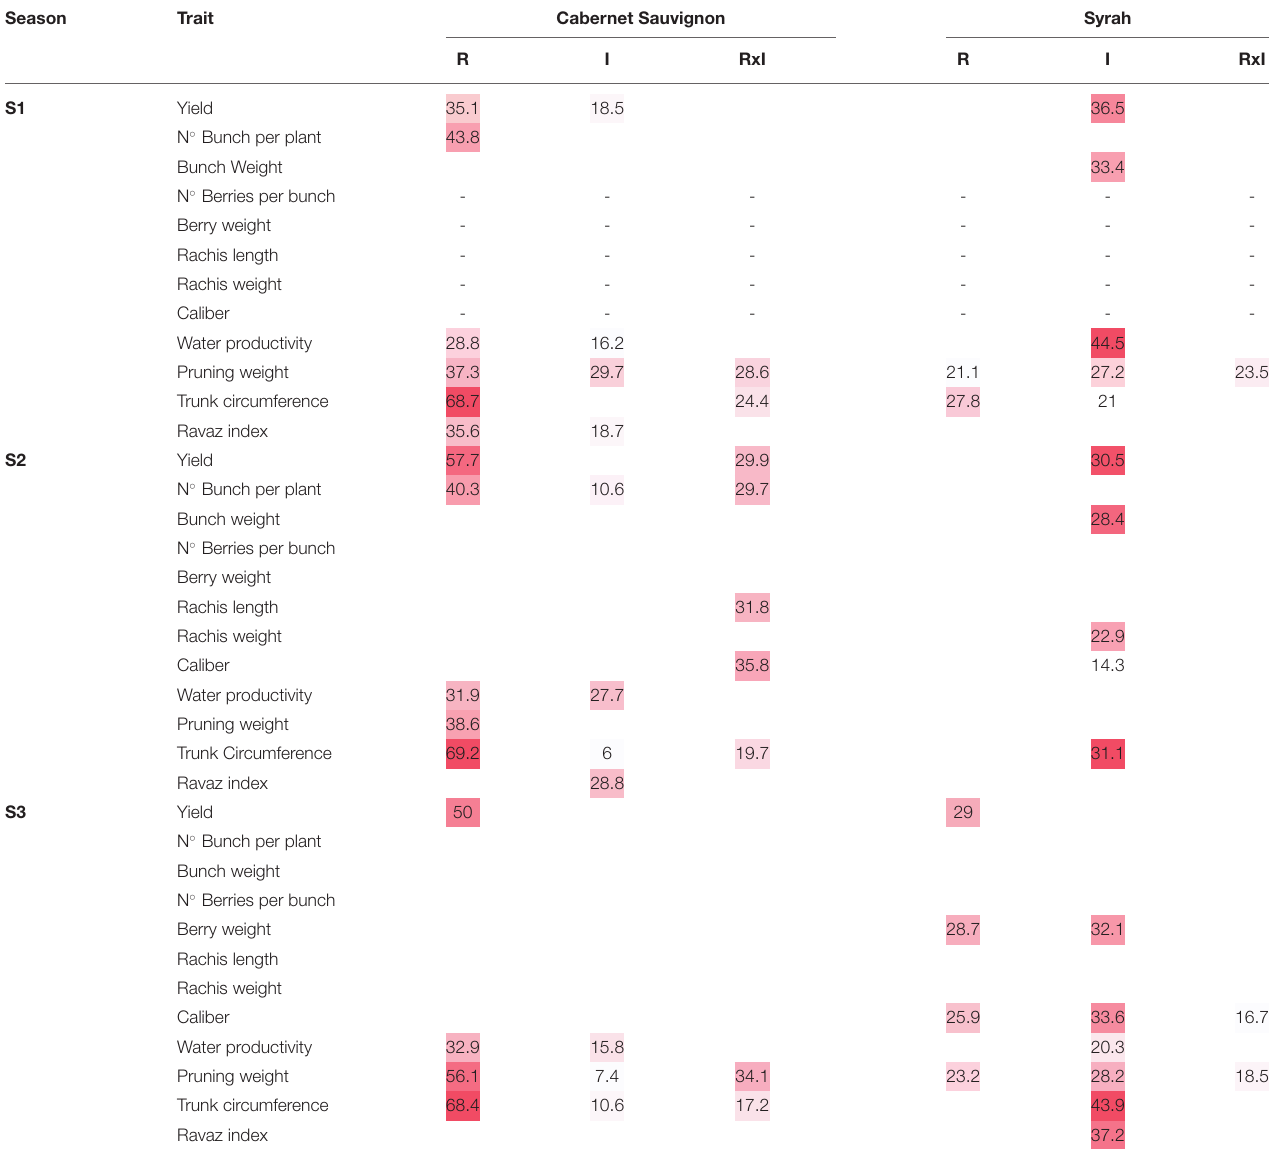
TABLE 5 | Percent of variance explained by each factor (Rootstock and Irrigation) and the interaction (RxI) for the productive variables in each cultivar and season. Season